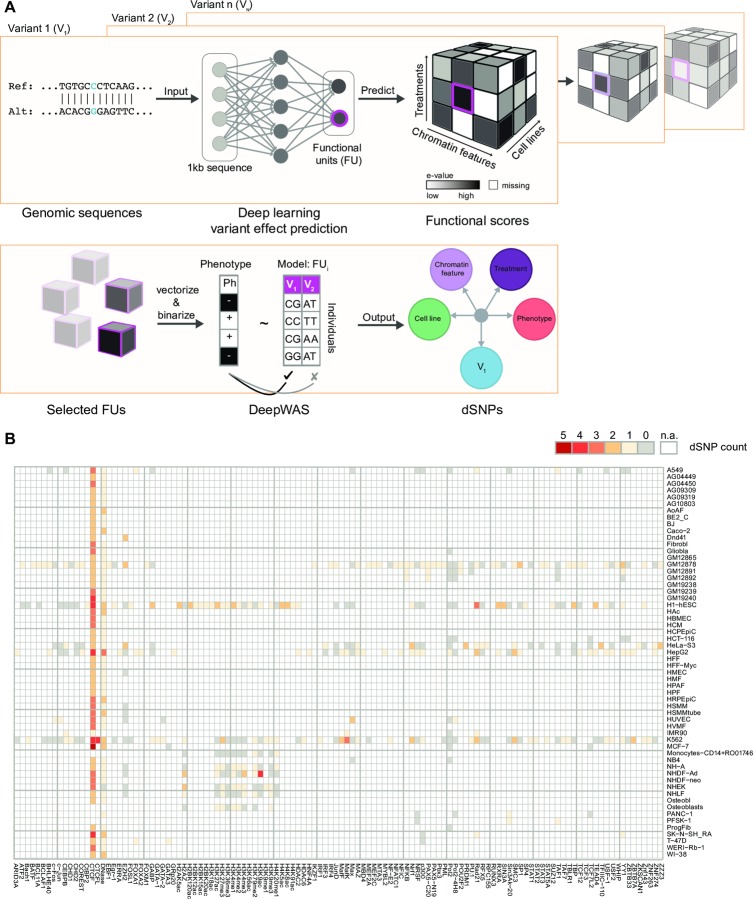
Workflow of DeepWAS.(A): A deep-learning based framework predicts combined binding probabilities for chromatin features, cell lines, and treatments, called functional units (FU) for 1,000 bp centered around a SNP. FUs are selected for a potential functional role of a variant using a cutoff for functional scores. This process is repeated for all genotyped variants. The genotype-phenotype association is analyzed for each FU using LASSO regression with stability selection. Unlike GWAS, DeepWAS implicates a regulatory mechanism underlying the phenotype of interest with information on relevant cell lines and TFs. (B): DeepWAS was applied to 36,409 regulatory SNPs that were retained after filtering for allele-specific effects in any given FU. These SNPs were tested for an association with multiple sclerosis (MS). The heatmap shows the number of selected chromatin features vs. cell lines. Chromatin features are limited to be present in at least two distinct cell lines. Missing values, represented in white, show FUs for which no data were available.